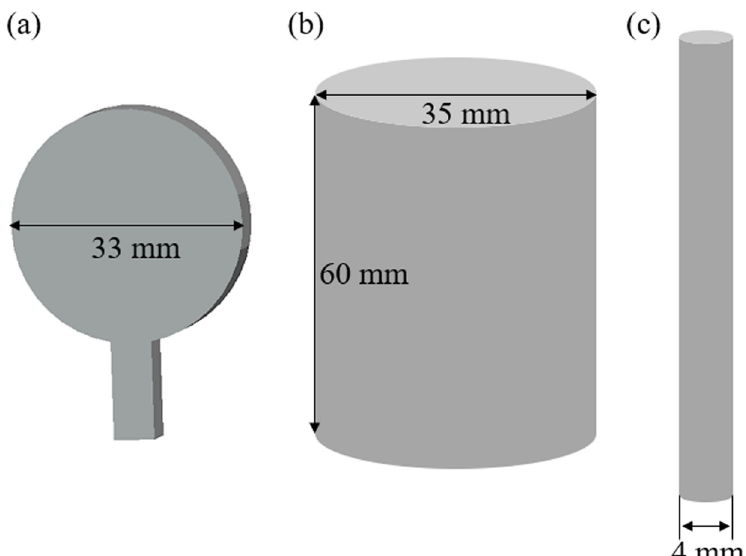
Figure 3. Steel samples taken from the end of LF process of ULC automotive steel; (a) racket sampler; (b) pail sampler; (c) acicular sampler.